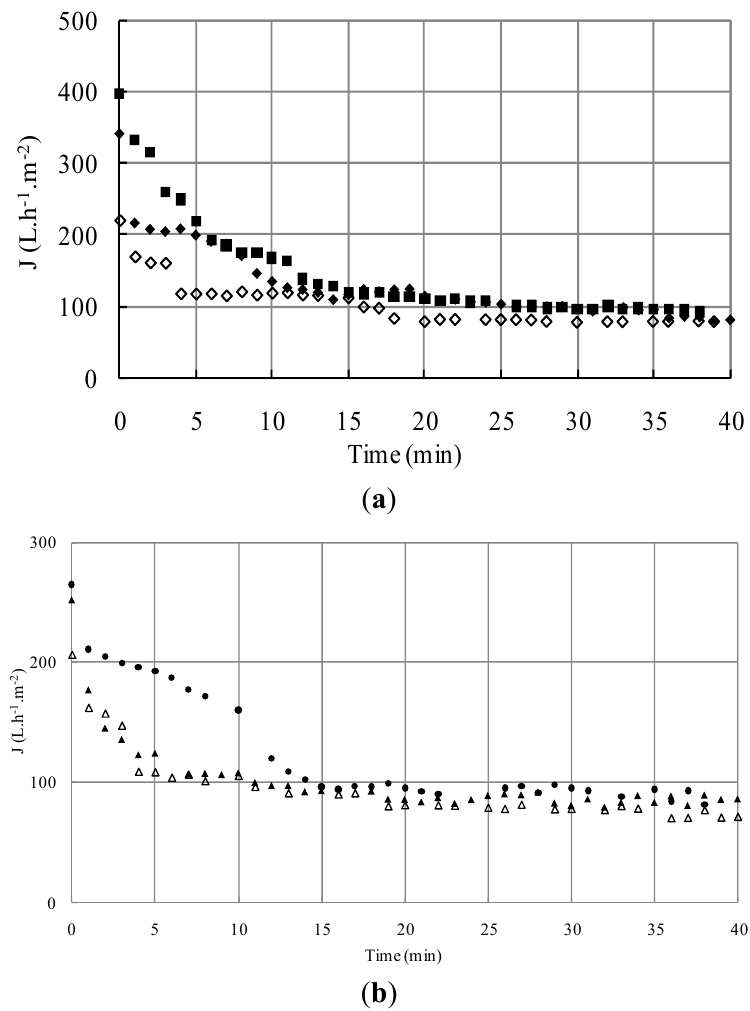
Figure 6. ( a ) Effect of initial cell concentration on microfiltration of the mixture: S. cerevisiae (6 g L − 1 ) and E. coli [0 g L − 1 (  S ); 0.15 g L − 1 (  S ); 0.3 g L − 1 ( ◊ S )] (TMP = 1.5 bar, 1 2 3 U = 2.38 m/s, R e = 5950); ( b ) Effect of initial cell concentration on microfiltration of ); 0.15 g L − 1 ( ▲ S ); the mixture: S. cerevisiae (10 g L − 1 ) and E. coli [0 g L − 1 ( ● S 5 6 0.3 g L − 1 ( Δ S )] (TMP = 1.5 bar, U = 2.38 m/s, R e = 7